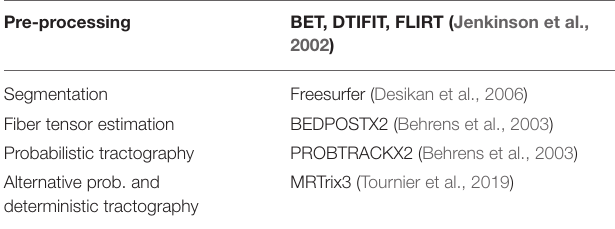
TABLE 1 | Software components of